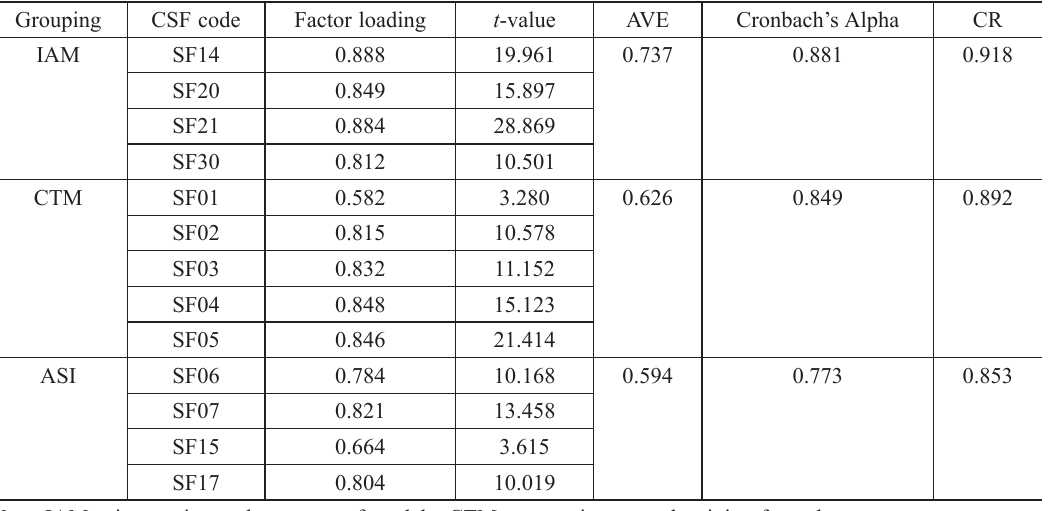
Table 5. CFA measurement model evaluation